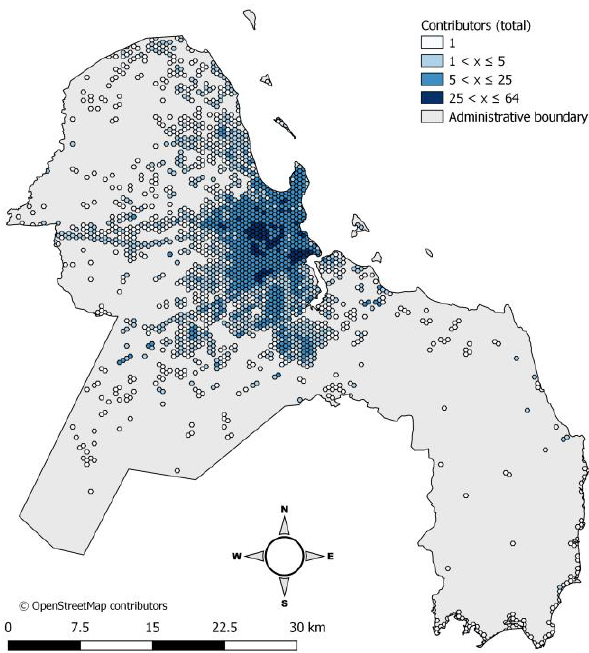
Figure 8. Dar es Salaam grid classified according to the average Figure 10. Dar es Salaam grid classified according to the total number of versions of OSM nodes (map data © OpenStreetMap number of different contributors on OSM nodes (map data © contributors). OpenStreetMap